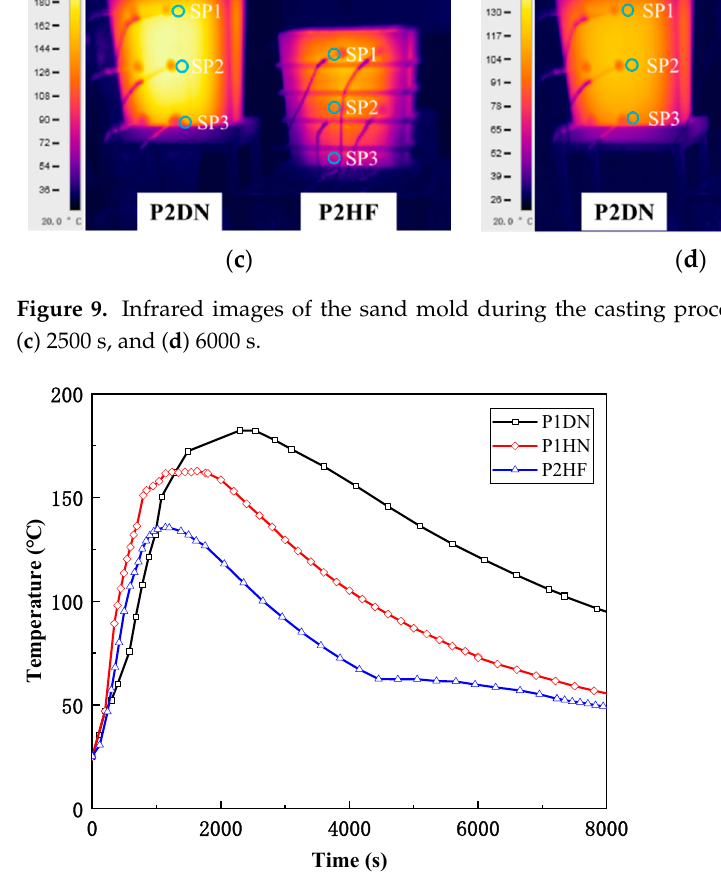
Figure 11. Temperature gradient between the top (SP1) and bottom (SP3) of the sand mold. 6.2. Effect on the Cooling Time of the Castings The cooling curves of the upper and lower parts (C1 and C2, as shown in Figure 7) of the castings and their temperature gradient curves under different conditions are shown in Figure 12. The casting of P1DN cooled faster in the early stage (0–1500 s) and slower in the later stage (after 1500 s) than that of P1HN and P2HF. Moreover, the cooling time to 200 °C of the P1HN and P2HF castings was shorter than that of the P1DN casting. During the solidification stage of the castings, P1DN casting has the fastest temperature decrease and the largest temperature gradient between C1 and C2. This is ascribed to the dense and thick sand wall of P1DN, which can absorb a large amount of heat. However, for the P1HN and P2HF castings, the sand mold was relatively thin, and the chill cooling effect was smaller than that of P1DN, resulting in the slow cooling of the casting at the